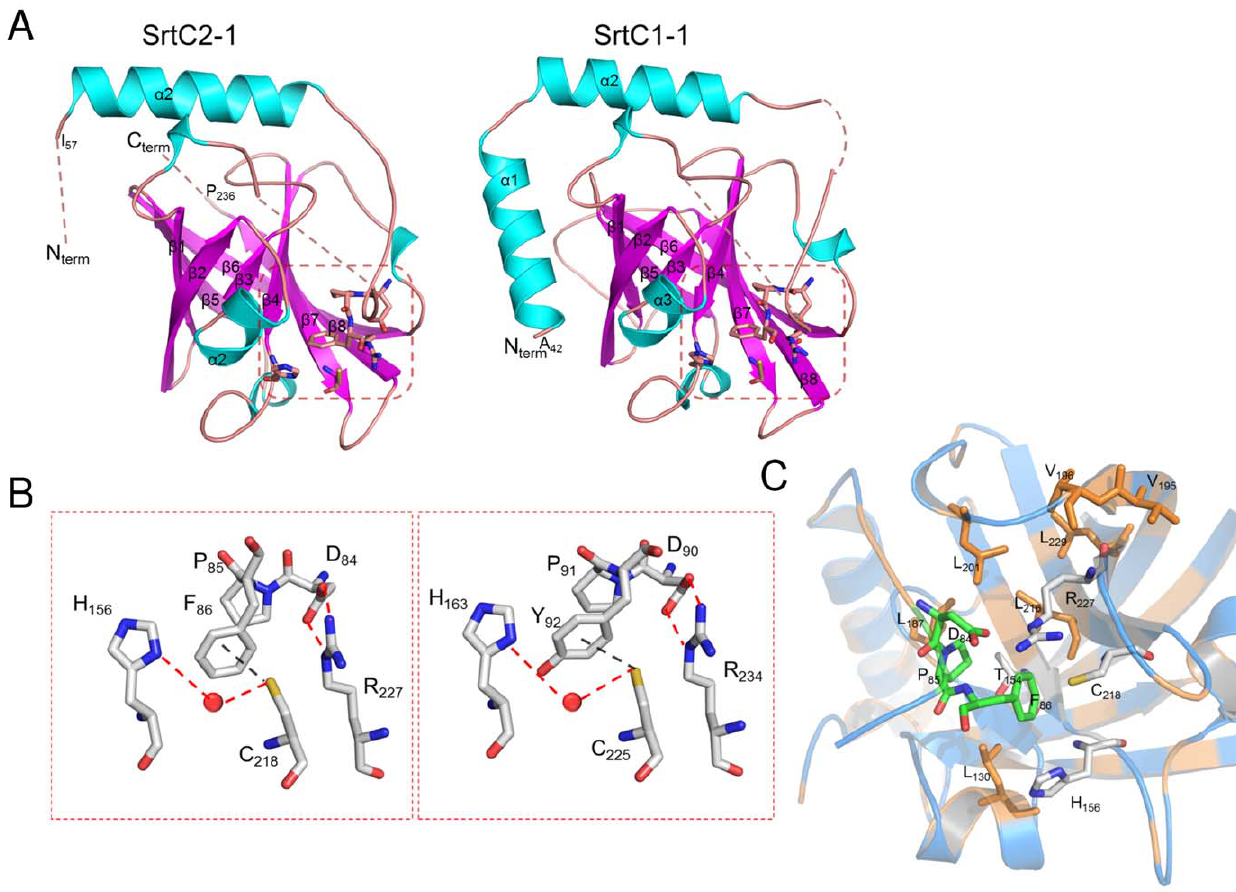
Figure 1. Overall fold of GBS PI-1 SrtC1 and SrtC2 and active site organization. (A) Overall fold of SrtC2 and SrtC1. Residues linking the mobile lid to the second helix and to the first beta-strand are missing in the final structures because of poor electron density, and are shown here as dashed lines. (B) Active sites of SrtC2 and SrtC1. Residues forming the mobile lid (Asp84-Phe86 in SrtC2 and Asp90-Tyr92 in SrtC1) and the active site (H156, C218, R227 in SrtC2 and H163, C225, R234 in SrtC1) are shown as sticks where sulfur, oxygen, and nitrogen atoms, are depicted as yellow, red, and blue, respectively. Water molecules are shown as red spheres. (C) The DPX motif is proximal to the catalytic triad of SrtC2, which is surrounded by conserved hydrophobic residues shown as sticks, where carbon, oxygen, and nitrogen atoms, are depicted as salmon, red, and blue, respectively.